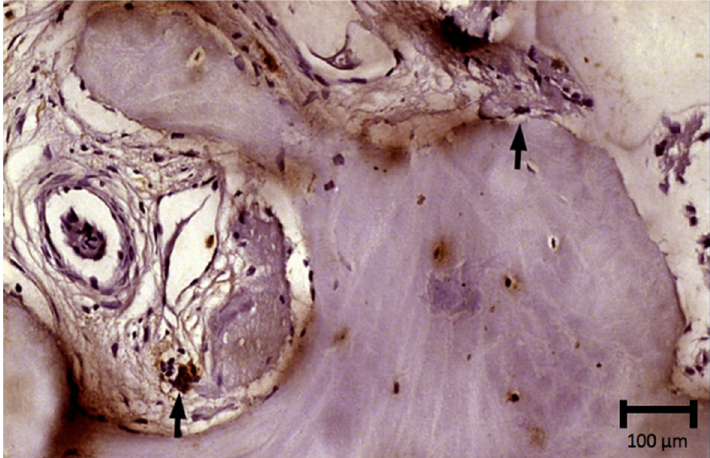
Figure 6- Histological section showing positive immunolabeling in cells for TRAP (→) in group 1. Harri’s hematoxylin stain, x25 magnification